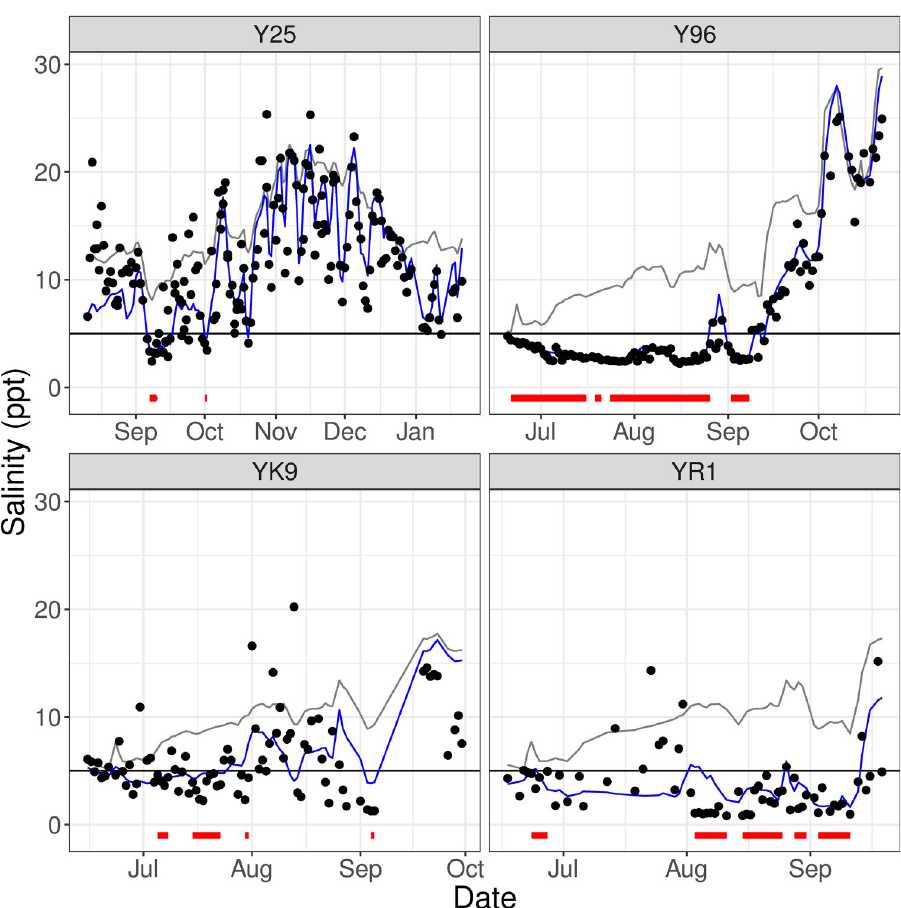
Fig 4. Predicted salinity exposures over time for dolphins in waters less than 5 parts per thousand (ppt) for at least five consecutive days. We compared each dolphin’s salinity exposure (based on their telemetry locations; black dots) to the median salinity within their potential ranging area (PRA) (blue line) and the median salinity across the Barataria Basin study area (grey line). The range and trend of dolphins’ salinity exposures was typically more similar to their potential ranging area than the overall median basin salinity, and several dolphins spent most of the time while they were tagged in waters < 5 ppt. Each dolphin in this subset spent one or more periods of at least five consecutive days in waters < 5 ppt (red